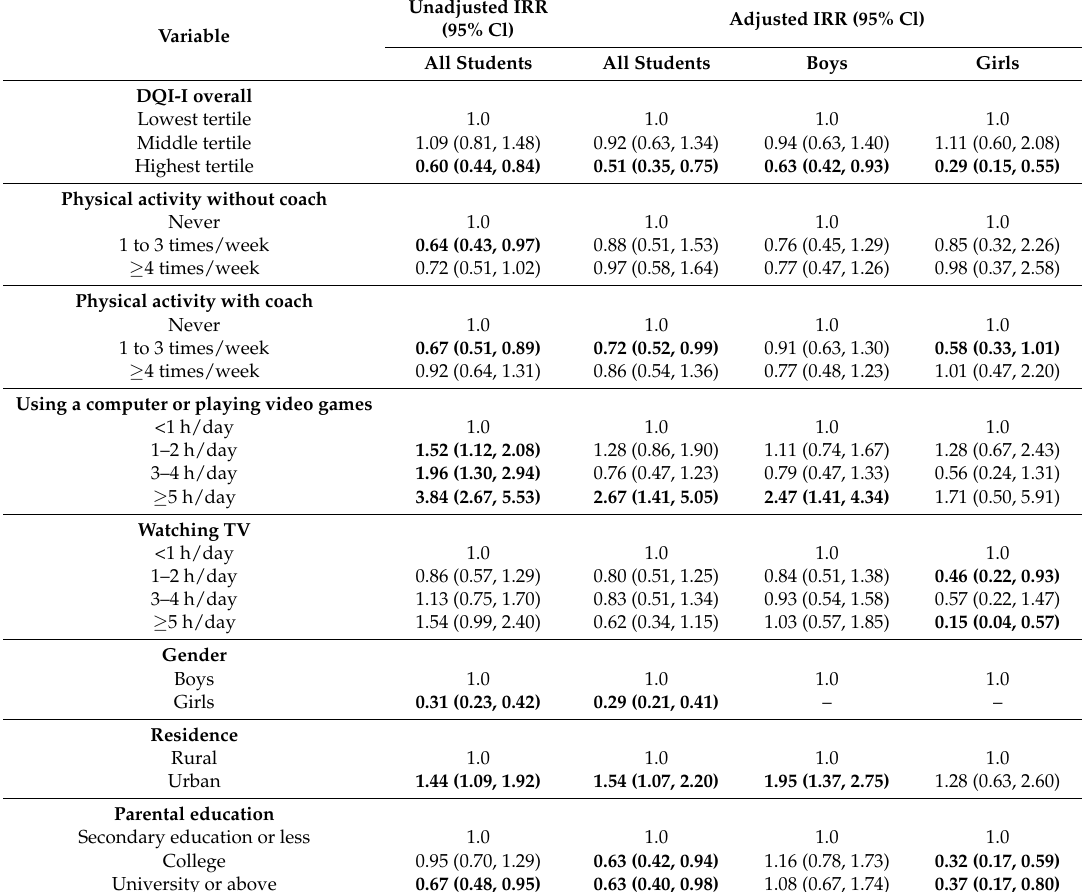
Table 2. Incidence rate ratios (IRRs) and 95% confidence intervals (CIs) for diagnoses of ADHD by the health behaviours, self-esteem, and socio-demographic variables among grade five students participating in the Children’s Lifestyle and School Performance study, Nova Scotia,